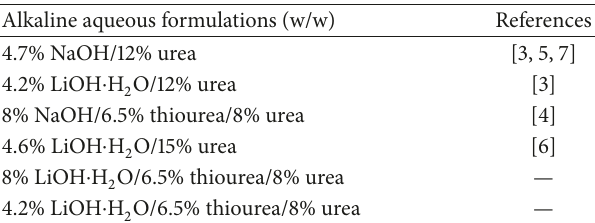
Table 1: Alkaline aqueous solvent test